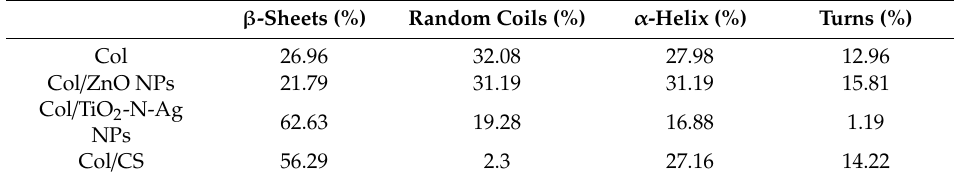
Table 4. Amide I band deconvolution in the range of 1700 to 1600 cm − 1 evaluated for electrospun collagen glue samples.